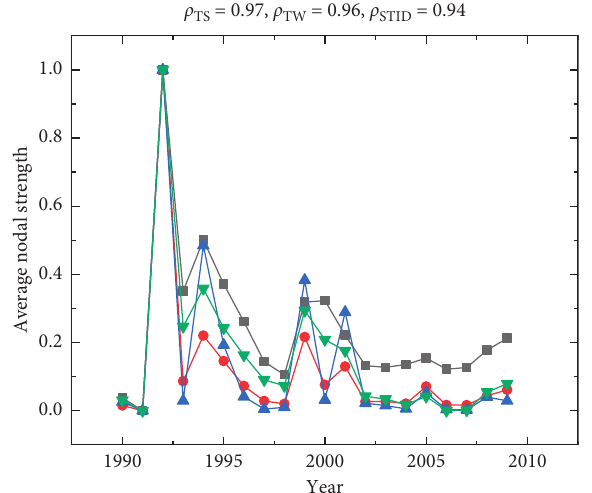
Figure 8: Evolution of the average nodal strength of the networks constructed by TS, TW, and STID. SumMag represents the sum of earthquake